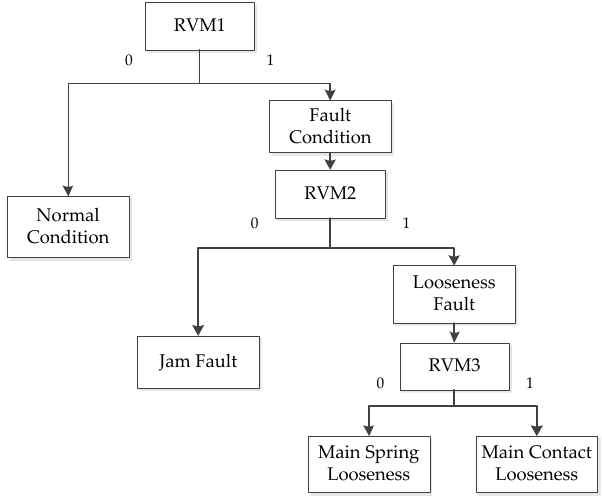
Figure 1. The multi-classification model of on-load tap-changer (OLTC) mechanical fault.